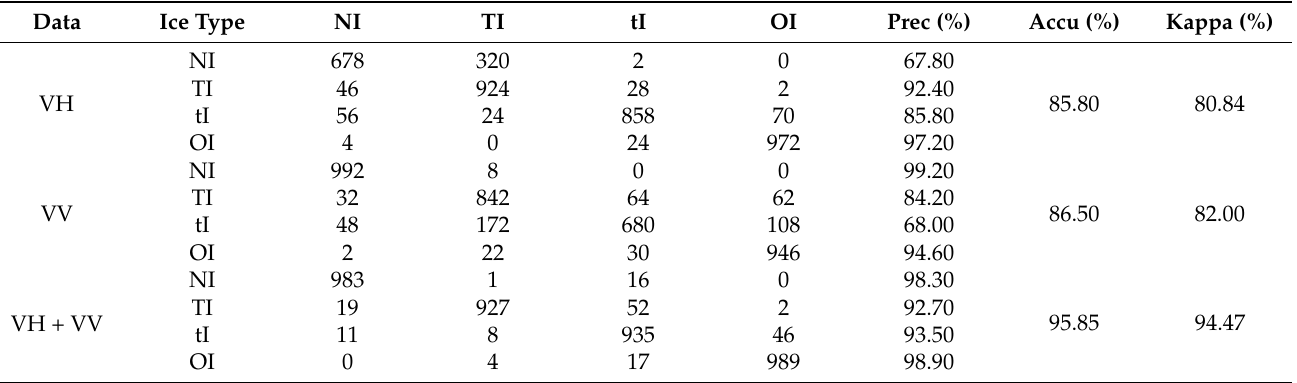
Table 5. Confusion matrix of classification results using VH polarization, VV polarization, and dual-polarization